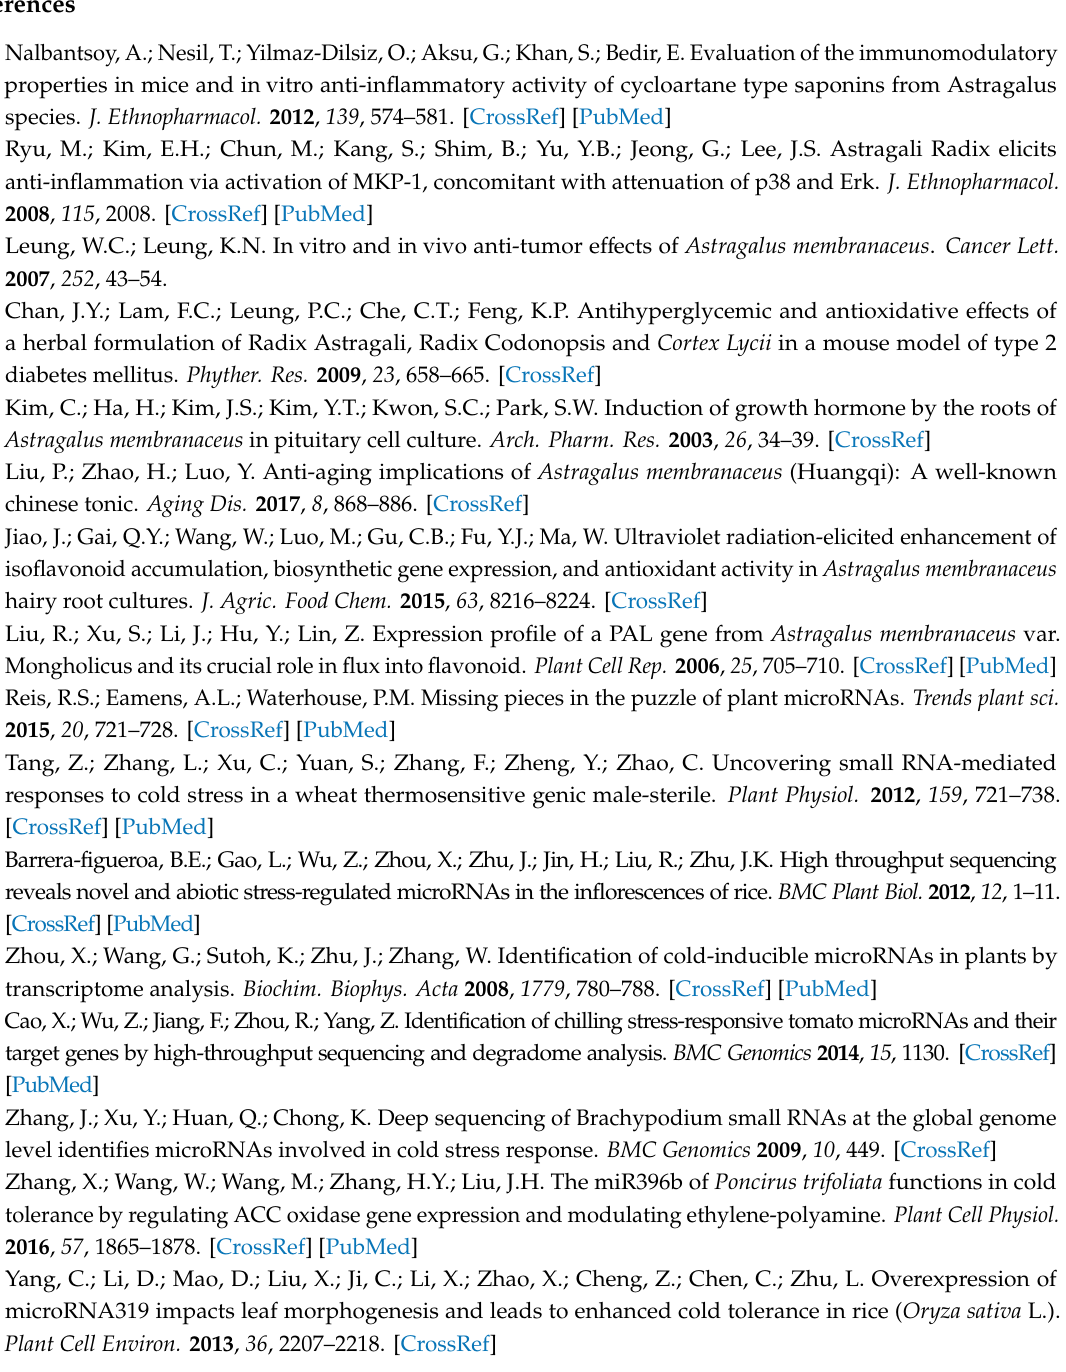
miRNAs. Table S5: The stem-loop precursors of the predicted non-conserved miRNAs, Table S6: The predicted targets of conserved miRNAs, Table S7: The predicted targets of the non-conserved